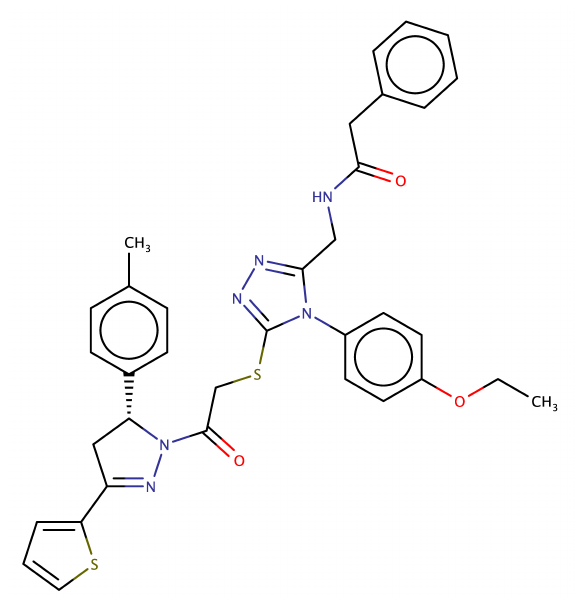
Figure 5. F0514-4011: N-[[4-(4-Ethoxyphenyl)-5-[2-[3-(4-methylphenyl)-5-thiophen-2-yl-3,4-dihydropyrazol